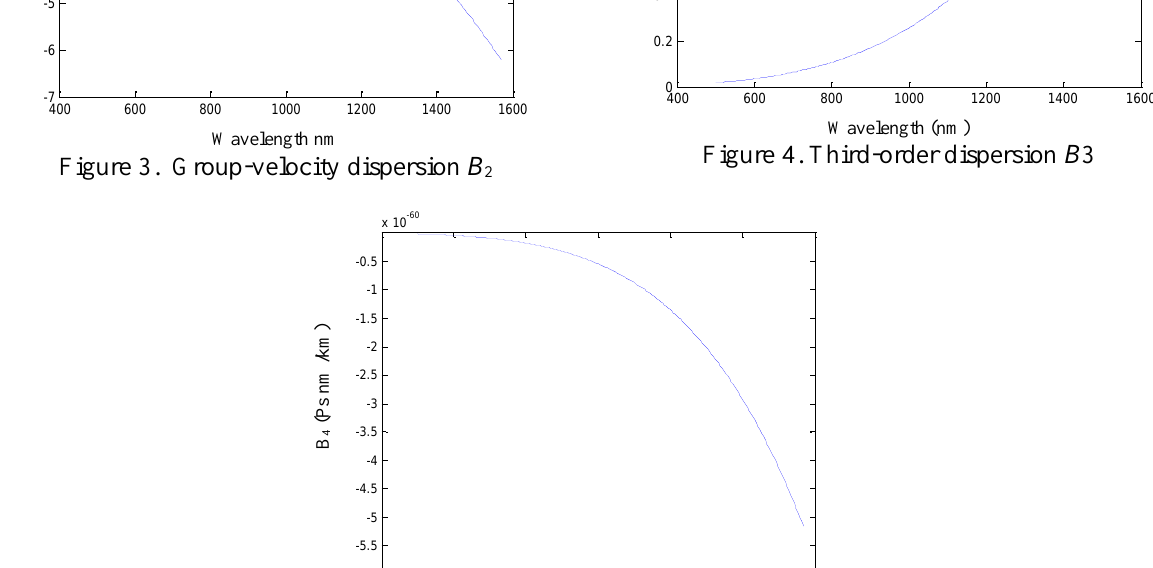
Figure 5. Fourth order dispersion B